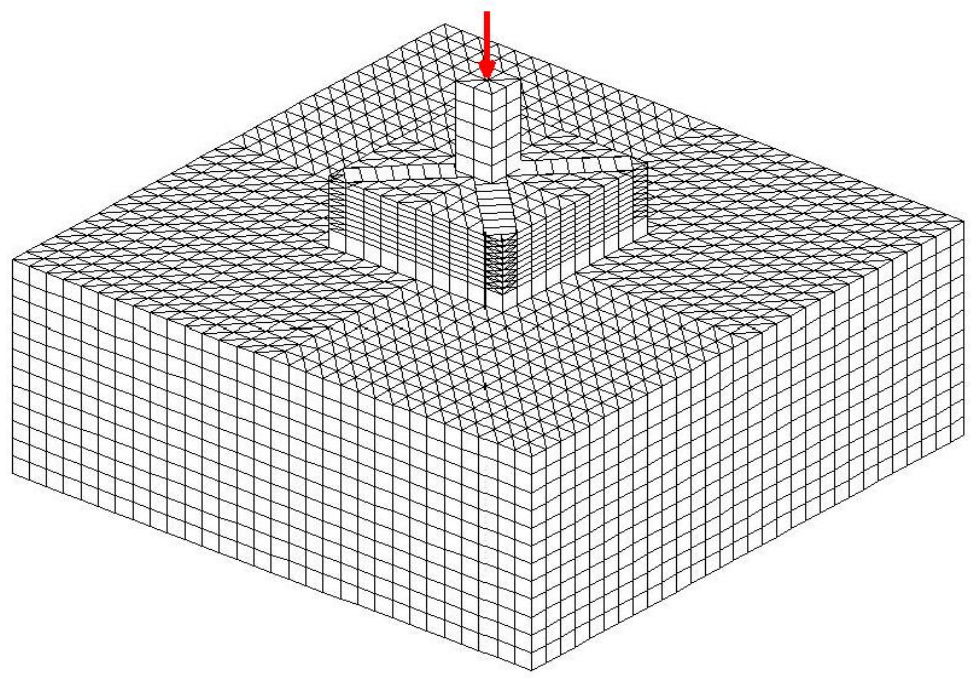
Figure 3. Finite element modeling of the initial shallow foundation fixed at the surface of the